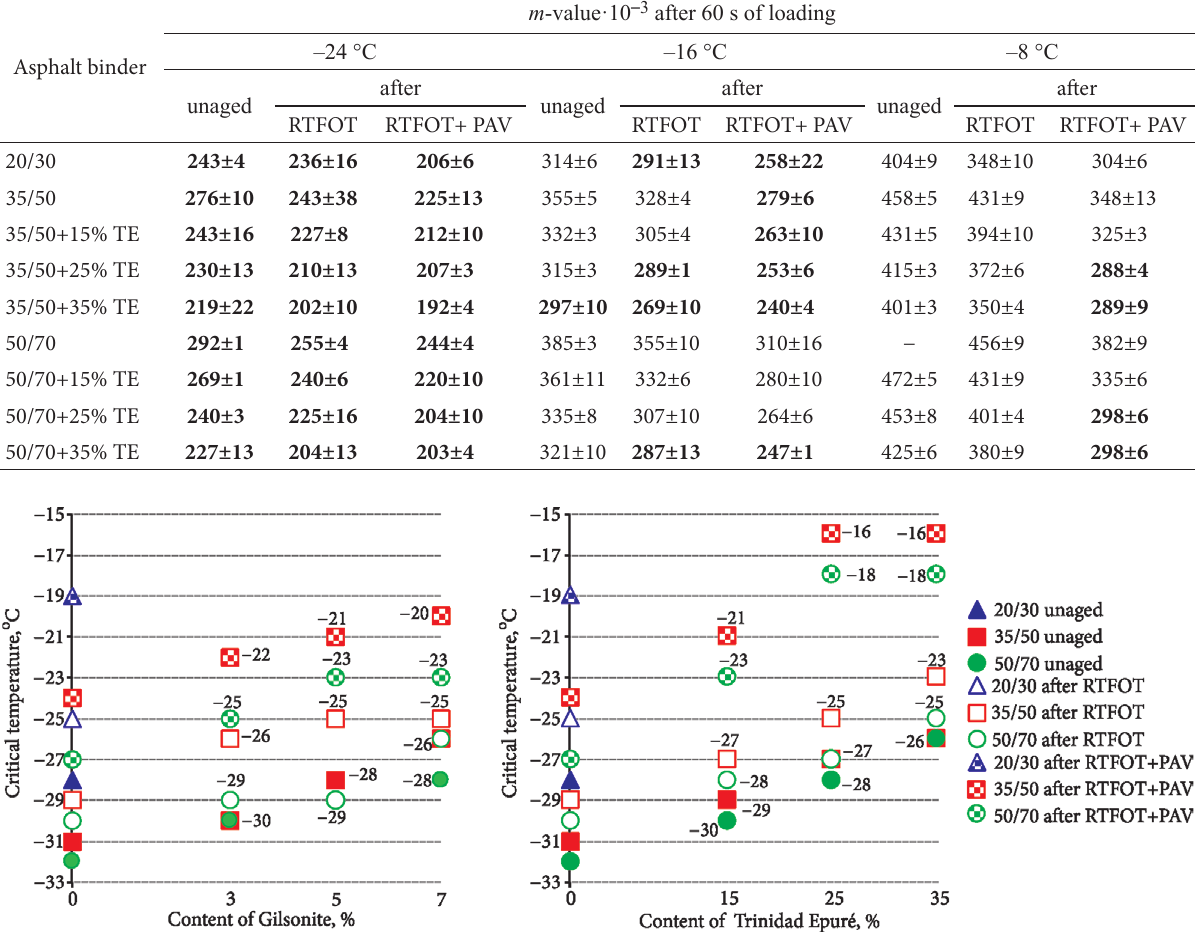
Fig. 4. Mean values of the critical temperature determined for the Gilsonite and Trinidad Epuré modified asphalt binders using the BBR